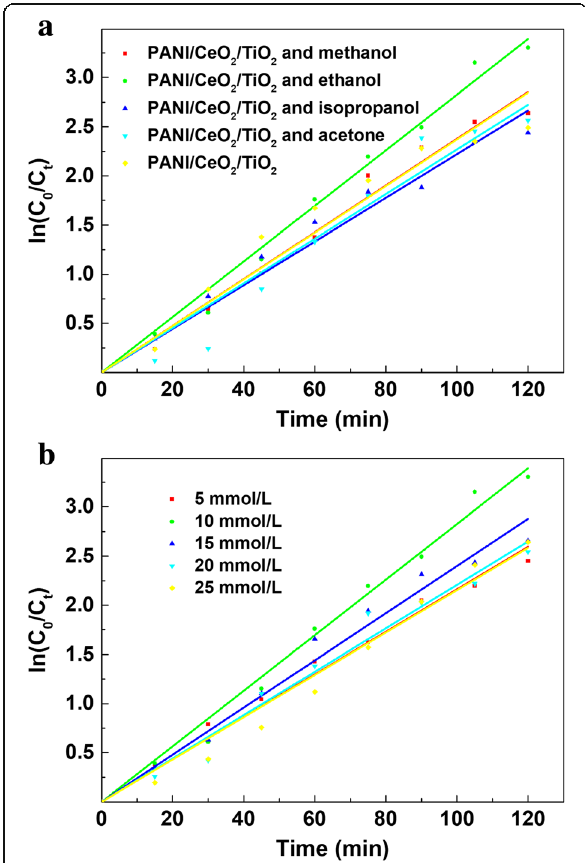
Fig. 5 The effect of different hole scavengers ( a ) and ethanol amount ( b ) on the kinetics of TBBPA degradation. The geometric surface area of TiO 2 electrode was 2.0×2.5cm 2 . Initial concentration of TBBPA: 10mgL − 1 , volume: 50mL, electrolyte: 0.05M Na 2 SO 4 , bias potential: 9V, pH: 3